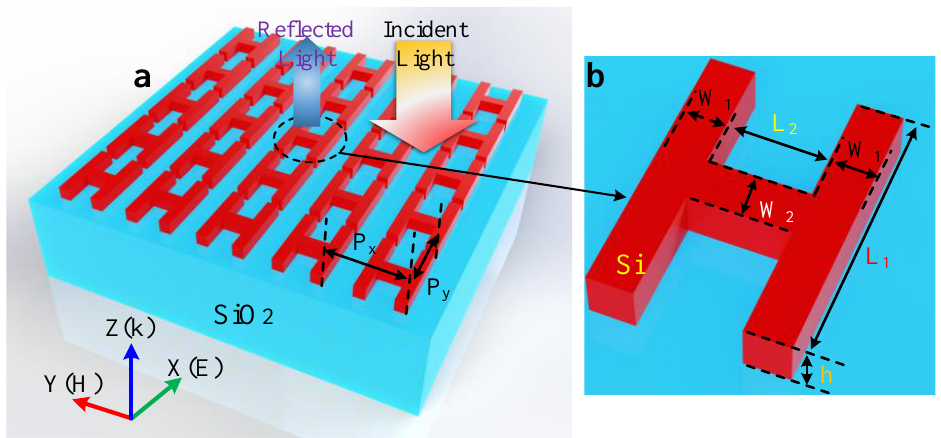
Figure 1. Schematic diagram of an all-dielectric color filter: ( a ) H-type silicon nanoarray, for nor- mally incident s -polarized white light; and ( b ) its unit cell.